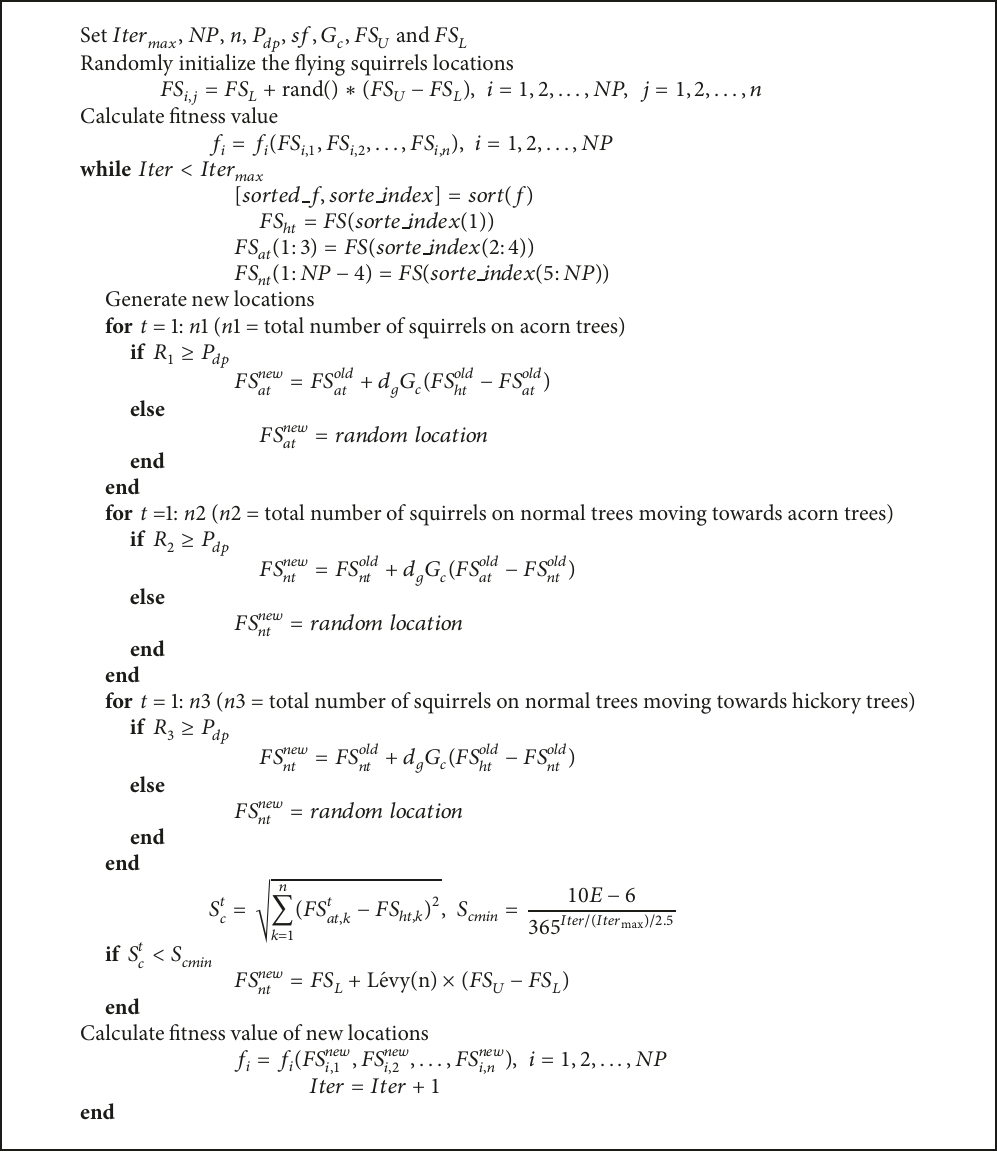
Algorithm 1: Pseudocode of basic